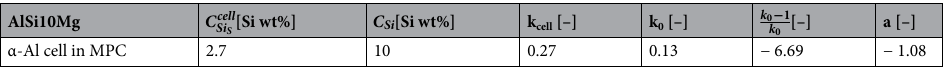
Table 5. Estimation of microsegregation parameter, a, based on local Si solid solution content in the α-Al cell cellular region ( C Si S ) measured by STEM-EDX. The equilibrium partition coefficient for Al-Si alloys is k 0 = 0.13 19 .